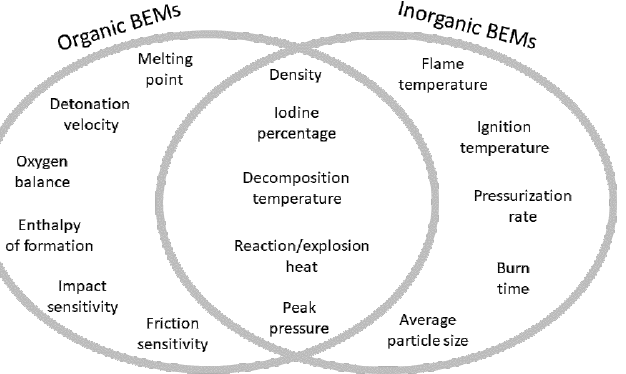
Figure 1. Scheme of the most important variables characterizing BEMs according to their basic chemical composition/formulation.